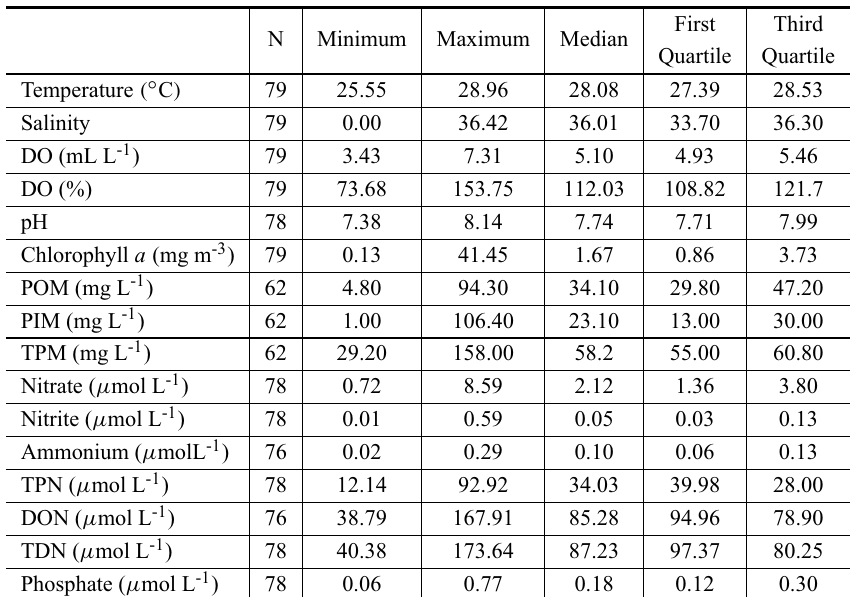
Descriptive statistics of the abiotic and chlorophyll a data recorded at the Amazon Continental Shelf in the euphotic layer, during the falling discharge period. Acronyms are as given in the text. N is the number of samples for which the statistical values were calculated.